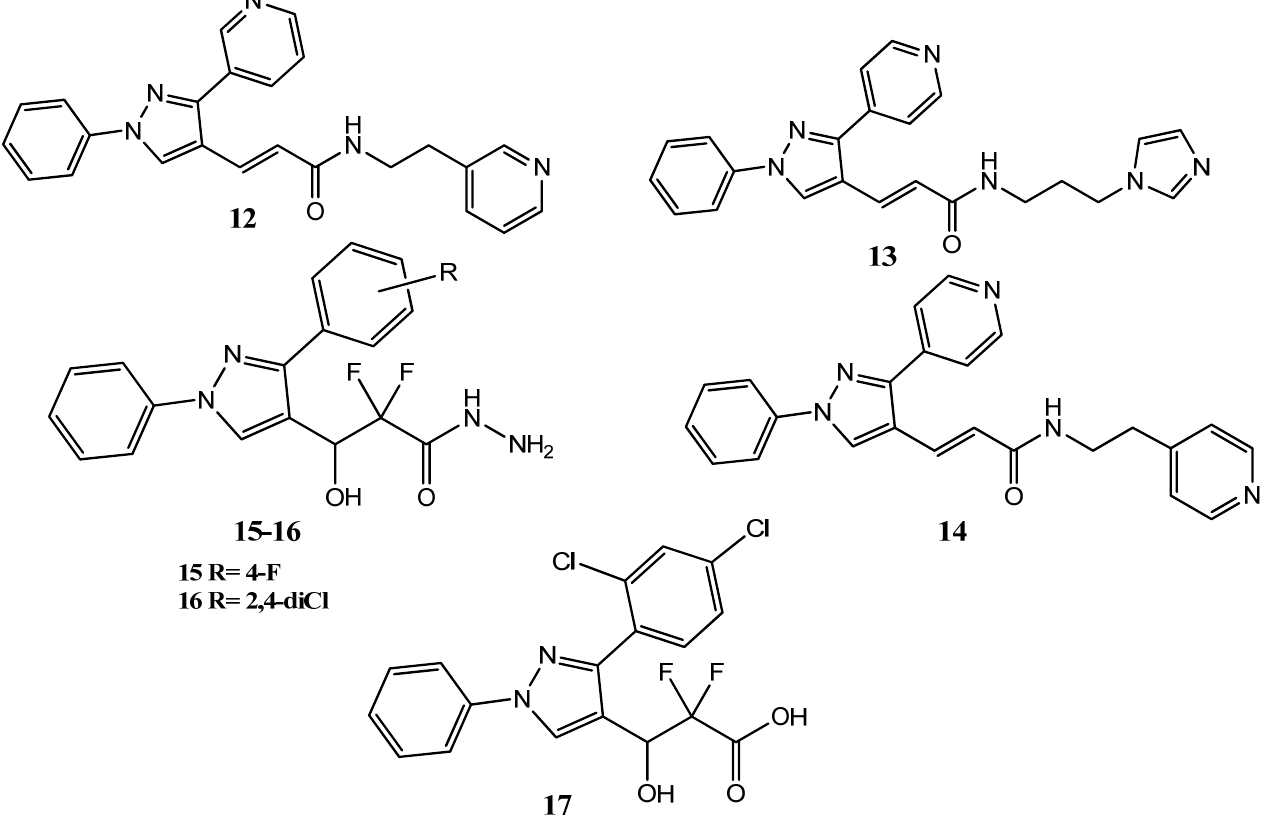
Figure 3. The 1,3–diaryl pyrazole derivatives.